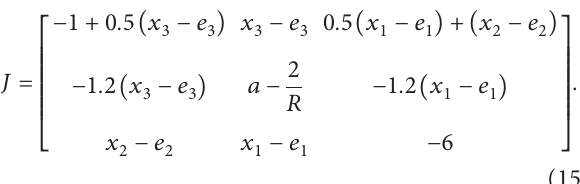
Figure 10: Variation of the absolute error err( t ) with different C values and R � 1.0.